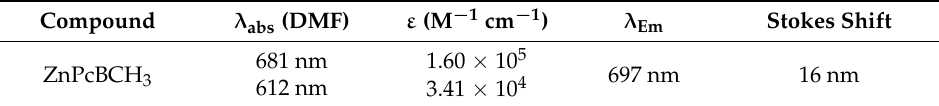
Table 2. Absorption data recorded in DMF.